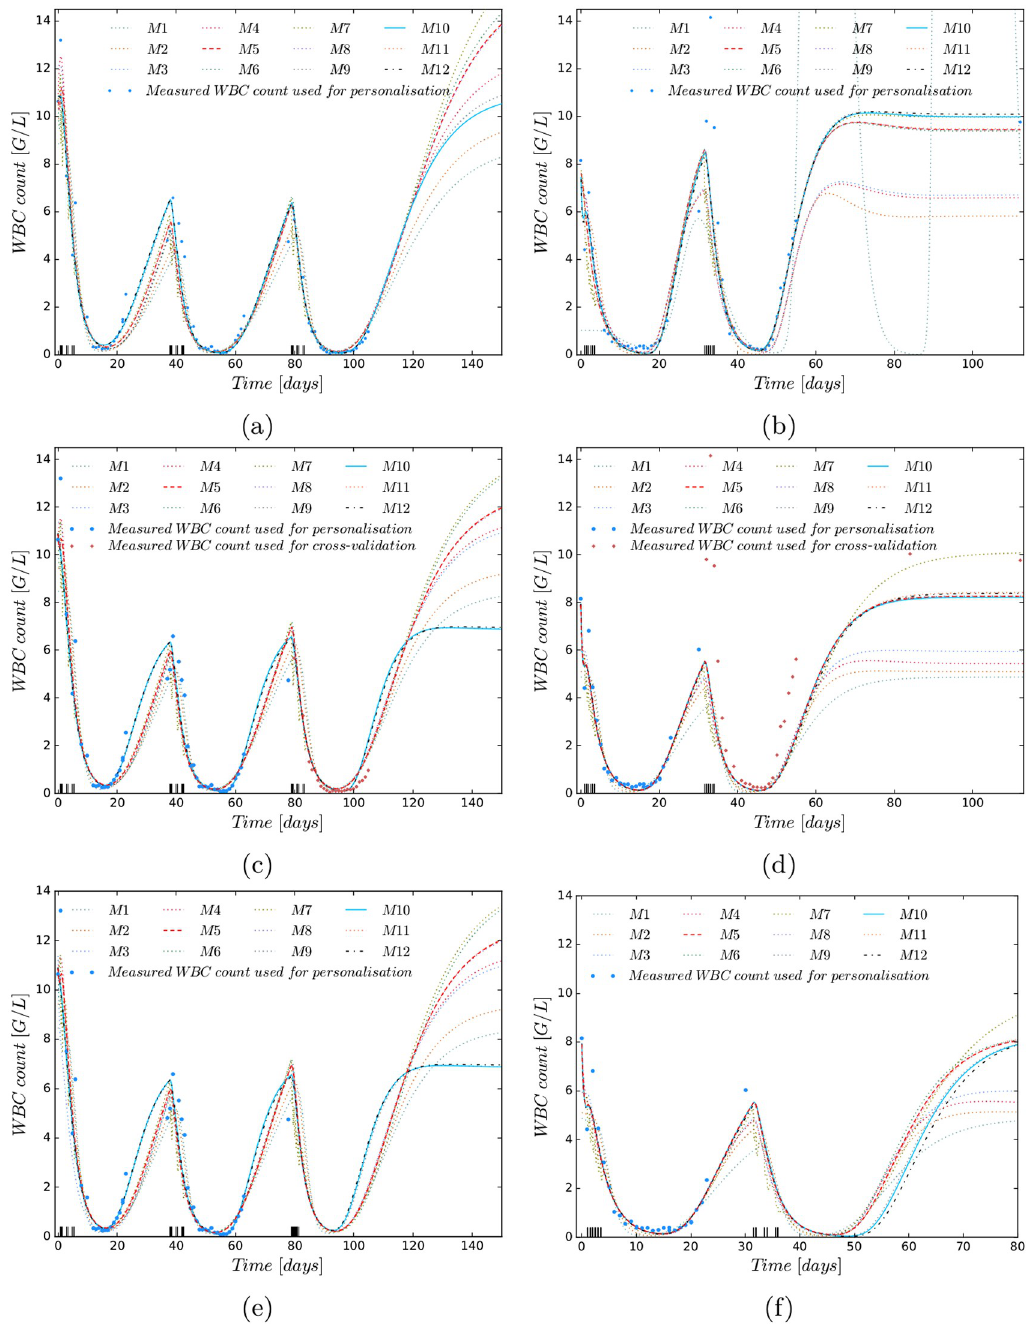
Fig 4. Comparison of personalised models (PMs) based on M1-M12 and white blood cell (WBC) data. Patient with three D135 cycles (left) and patient P D123 with two D123 cycles (right), as indicated on the x-axis. The PMs exemplify reproducability (first row), predictability (second row) and simulation of a different schedule in prediction than estimation (third row). ( a ) Reproducability: all 12 PMs based on M1–M12 are able to explain the measured WBC counts. ( b ) As in (a), all PMs explain the measured WBC counts well, particularly around the nadirs. ( c ) Cross-validated prediction: all PMs explain the WBC counts well, also in the predicted third cycle. ( d ) As in (c), here with a slightly too slow predicted recovery time in the second cycle for all models. (e) Varied Ara-C schedule: prediction of D123 in the third cycle for a PM based on two D135 cycles shows faster WBC recovery for M9, M10, and M12. (f) Prediction of D135 in the second cycle for a PM based on one D123 cycle shows slower WBC recovery times for M9, M10, and